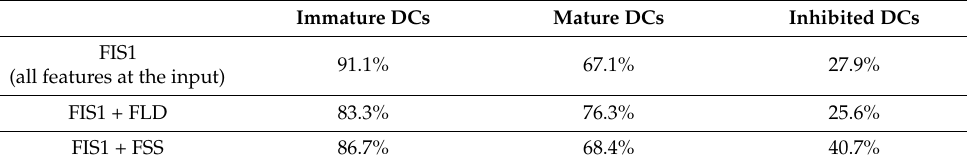
Table 5. Correct classification rate of the three classes with the FIS1